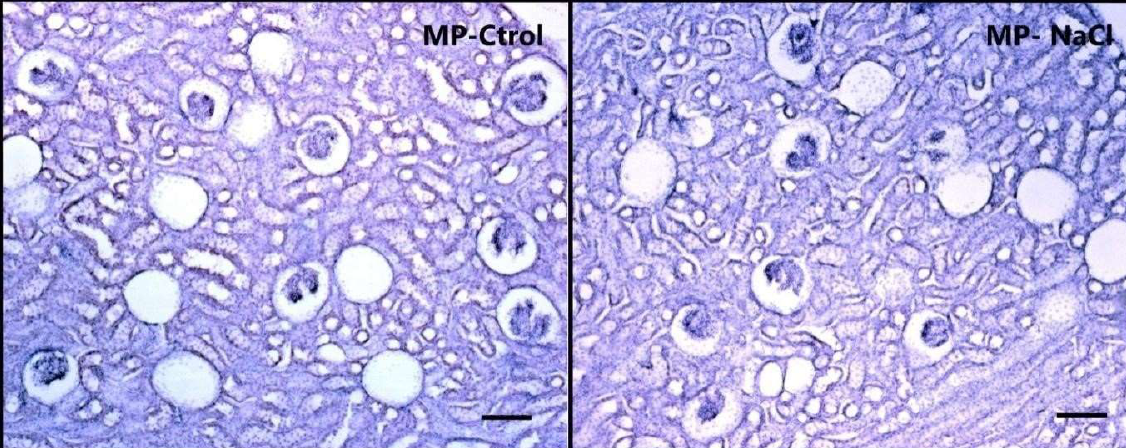
Figure 3. Sodium programming effects on kidney histology. Photomicrographs showing the histo- logical pattern of glomeruli in the renal cortex stained with hematoxylin and eosin from basal PM Ctrol ( left ) and PM-NaCl ( right ) animals. Photographs are shown at 5X magnification. Scale bar: 100 μM .